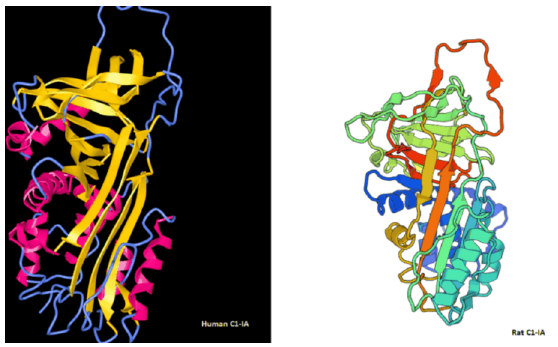
Fig 4. Protein structure for (left) human C1-IA and (right) rat C1-IA (model from Swissmodel.expasy. org). The humanC1-IA consists of 500 amino acids, whereasthe rat C1-IA consists of 504 amino acids with a sequenceidentity of